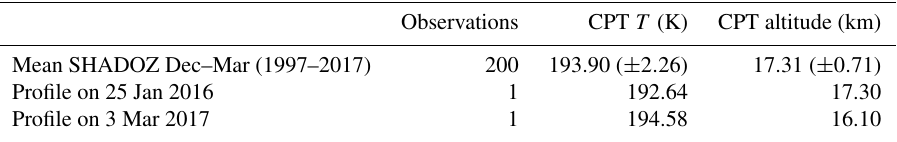
Table 1. CPT properties (temperature and height) from the radiosonde launches on 25 January 2016 and 3 March 2017 and NDACC/SHADOZ seasonal mean (December–March) CPT properties (for the period